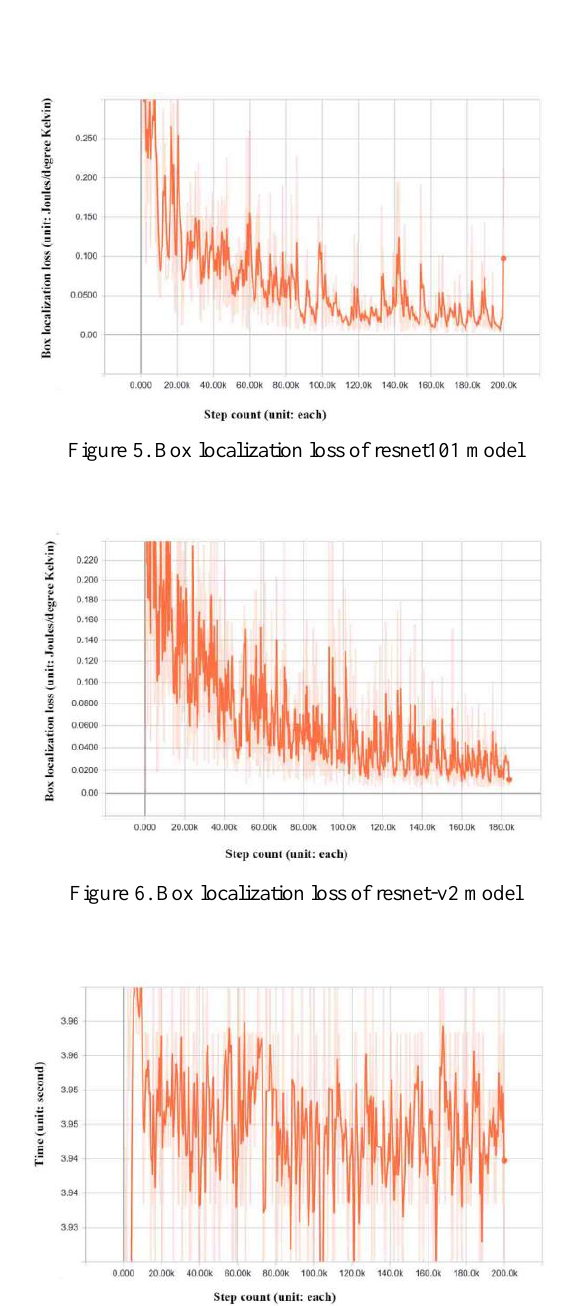
Figure 7. Global step time cost of resnet101